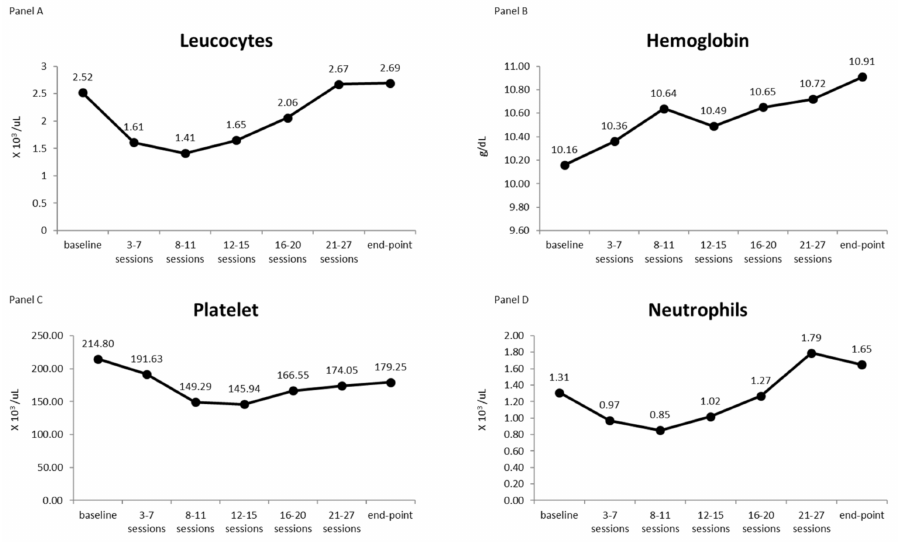
Figure 2. The four panels show the trend over time of the median values of leucocytes (panel A ), hemoglobin (panel B ), platelets (panel C ), and neutrophils (panel D ) as a function of the treatment sessions. Table 3. Results of the statistical analysis performed with Wilcoxon signed rank sum test on the median values of leucocytes, hemoglobin, platelets, and neutrophils at baseline, the midpoint, and at end of